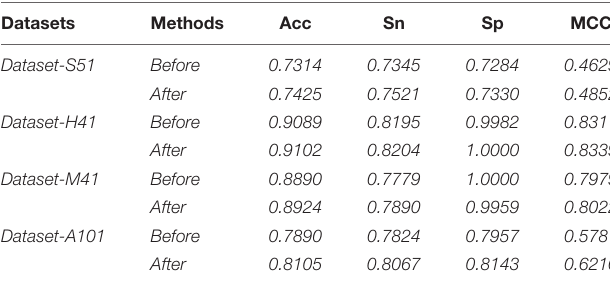
TABLE 3 | Performance of features before and after feature